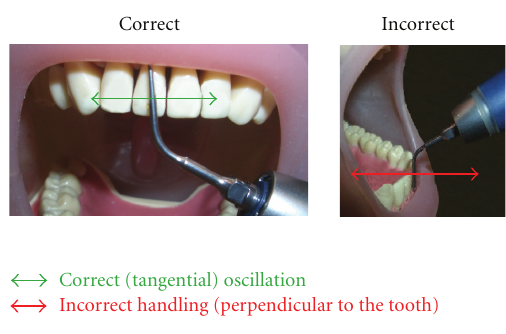
Figure 2: Handling of the scaler.